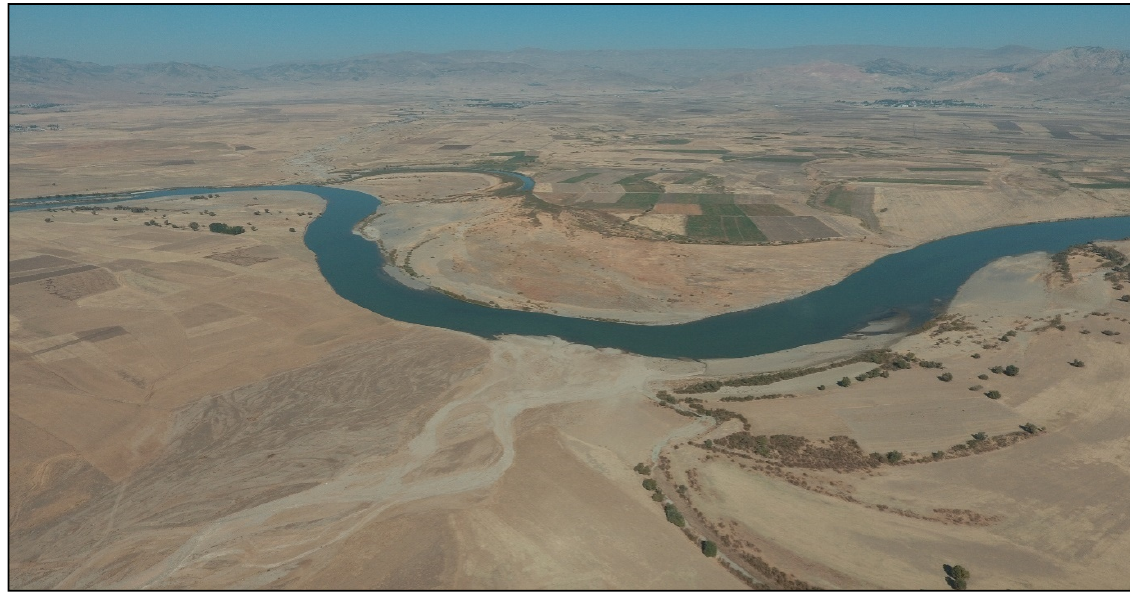
Figure 7. The present-day Murat River.